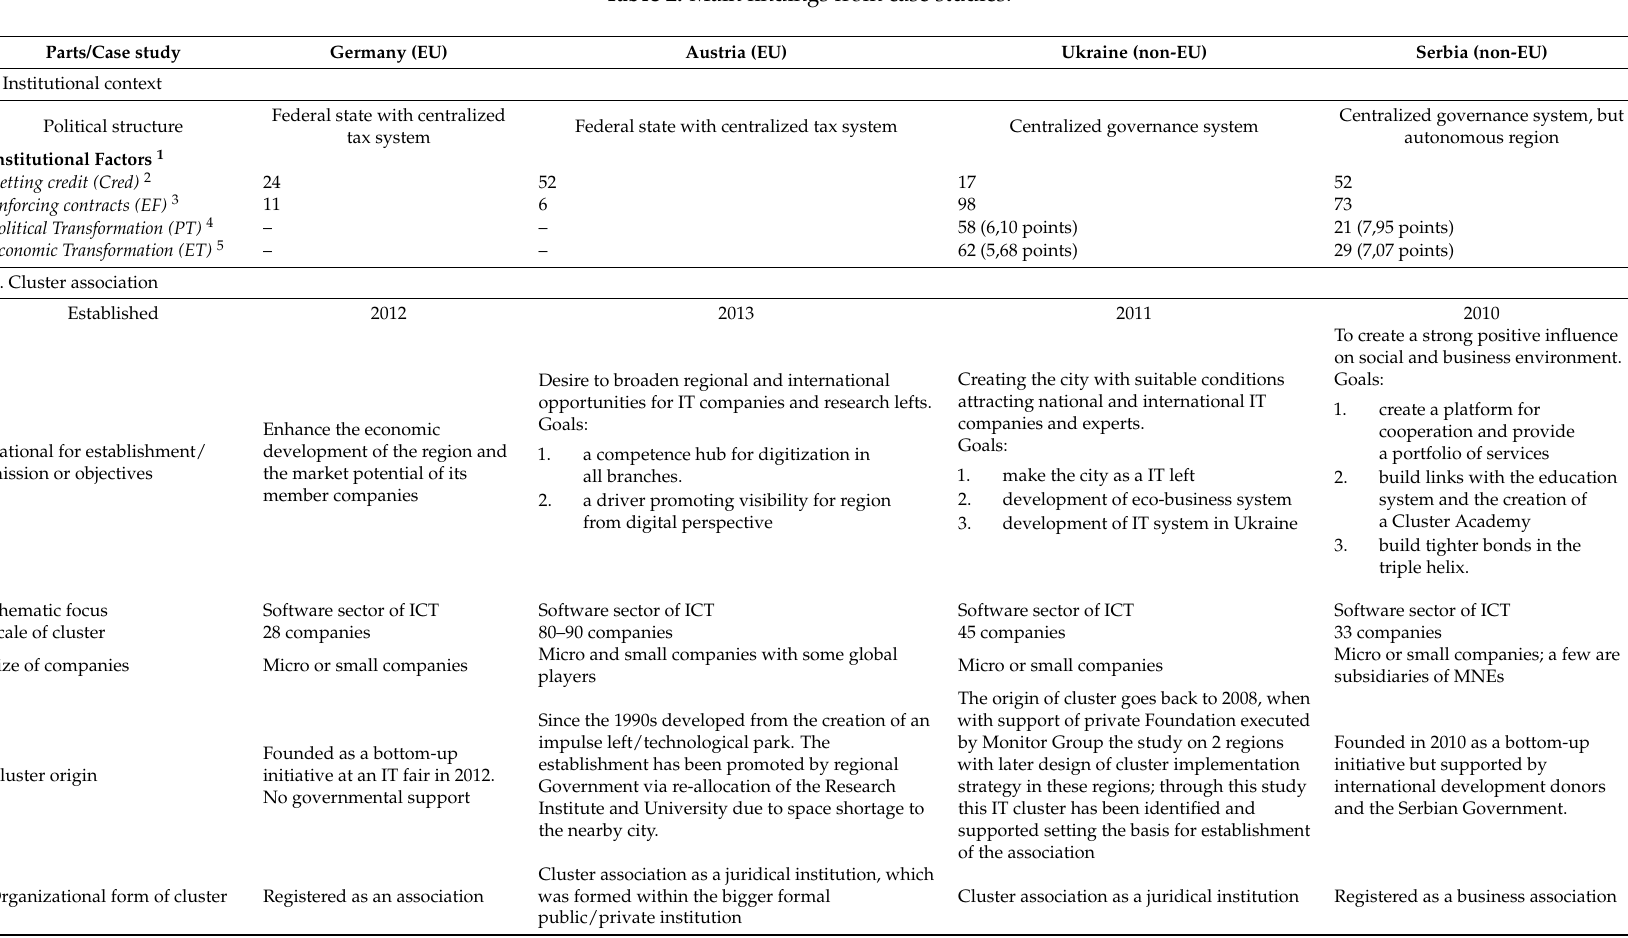
Table 2. Main findings from case